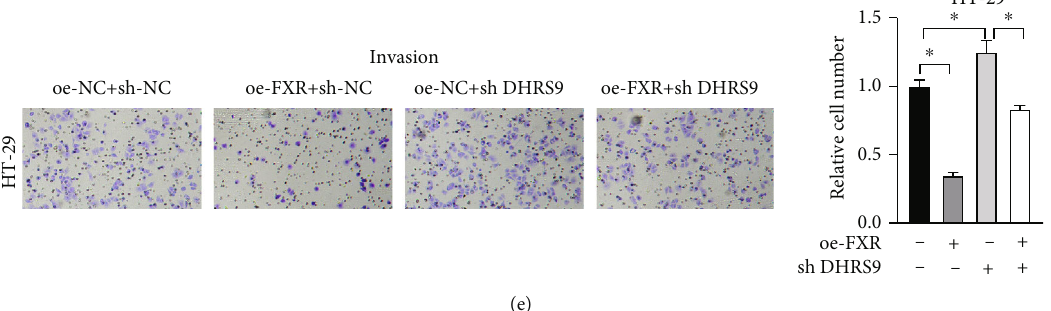
Figure 4: FXR activates DHRS9 to inhibit the malignant progression of colon cancer. (a) DHRS9 expression in transfected colon cancer cells detected by qRT-PCR. (b and c) E ff ect of FXR overexpression on HT-29 cell proliferation after DHRS9 expression blocking detected by CCK-8 and colony formation assays. (d and e) Changes in motor capacity of FXR overexpressed colon cancer cells after DHRS9 expression blocking assessed by Transwell migration and invasion assays. Each column is the average value of 3 independent experiments. ( ∗ denotes P < 0 : 05